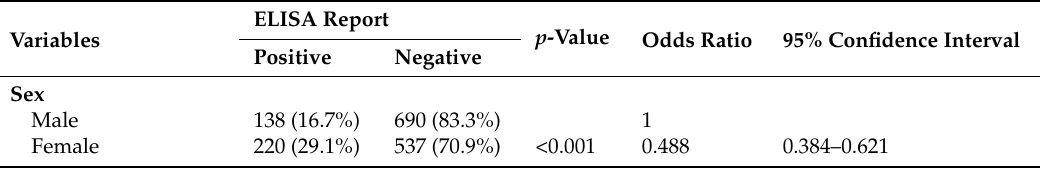
Table 1. Association of socio demographic variables and enzyme-linked immunosorbent assay (ELISA)